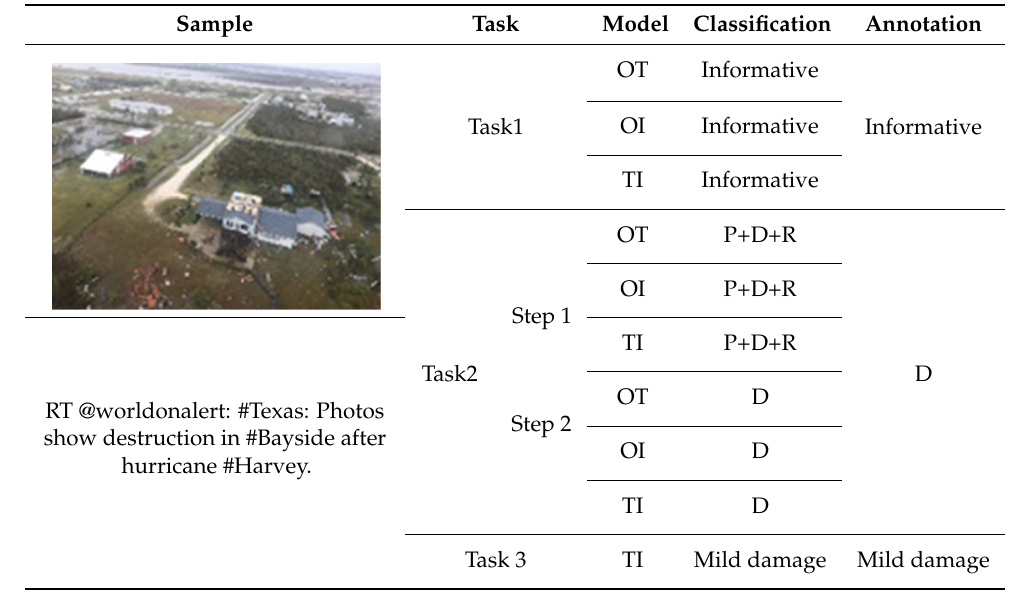
Table 10. The classification results of a sample with images, text, and annotations (OT: Only Text, OI: Only Images, TI: Text and Images).